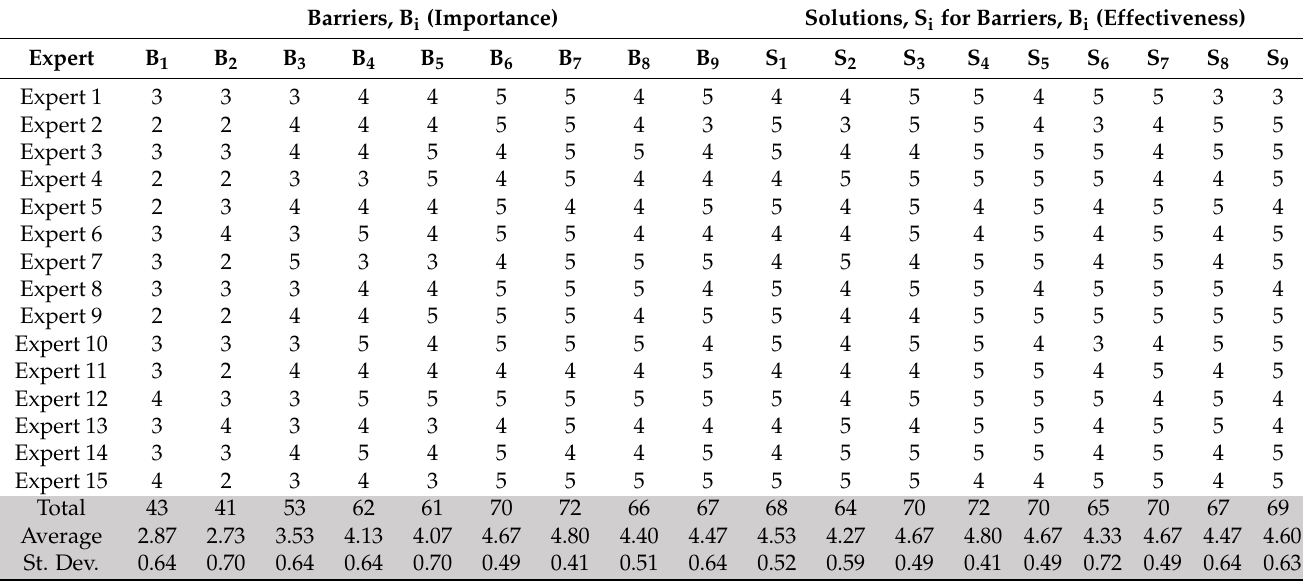
Table 4. Prioritization exercise and